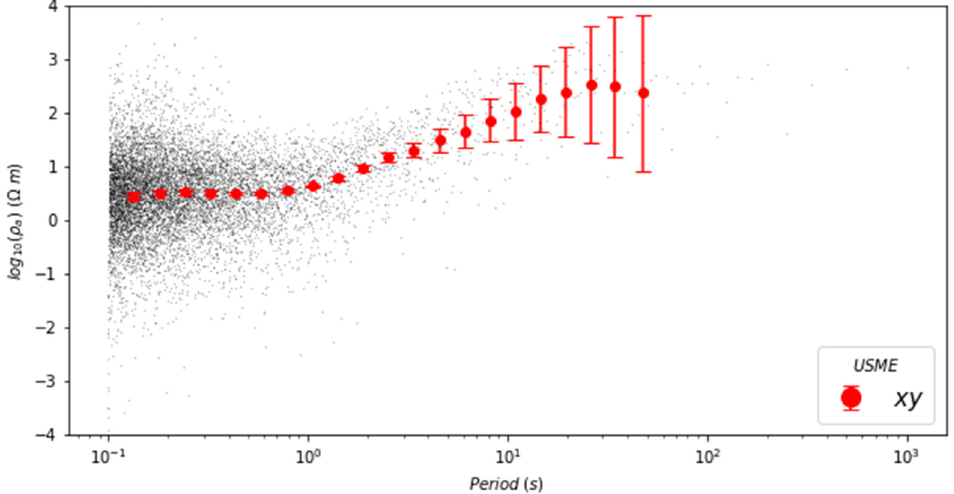
Figure 3. Apparent resistivity ρ a dispersion as a function of the period ( T ). The gray dots represent the raw data computed from Equation (3). The red dots represent the fitted curve used for the apparent resistivities of the partial time window (‘xy’ means HQE-HFN).